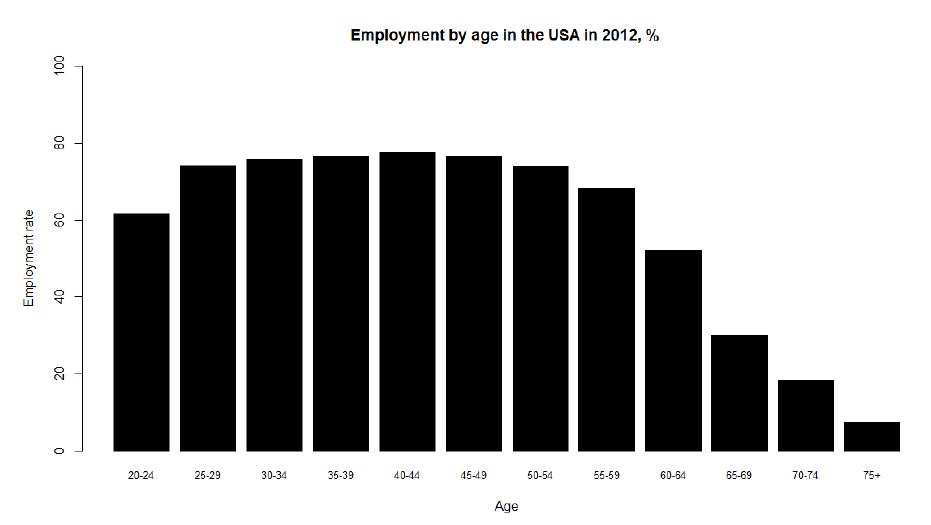
Figure 4. Employment rate by age group in the United States in 2012. The X-axis represents age and the Y-axis represents the employment rate, calculated as the ratio of employed population in the labor force to total population in the labor